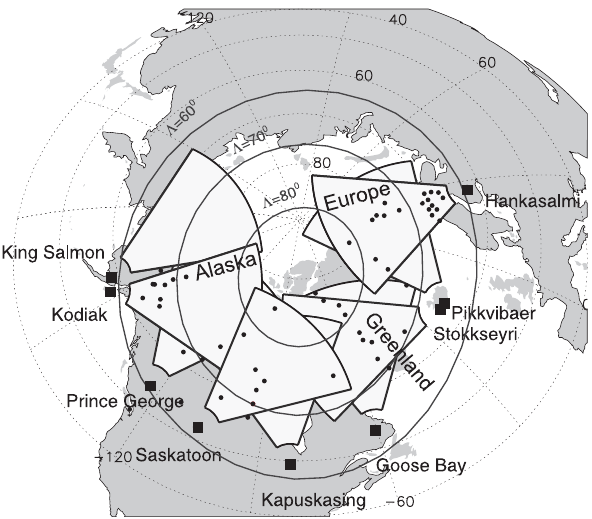
Fig. 1. A map showing the Northern hemisphere SuperDARN radar locations (bold squares), their FoVs (circular sectors), and the magnetometer locations (solid dots). Actual magnetometer data in these sectors (Alaska, Greenland, and Northern Europe) will be pre-